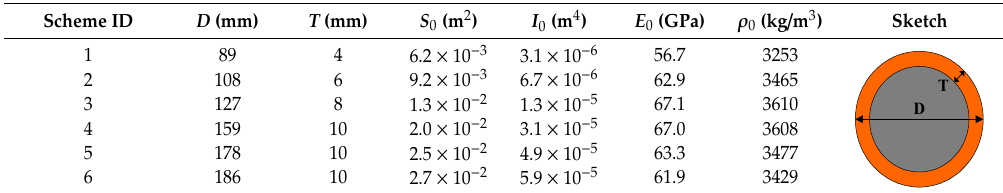
Table 3. Cross-section parameters of the pipe roof.